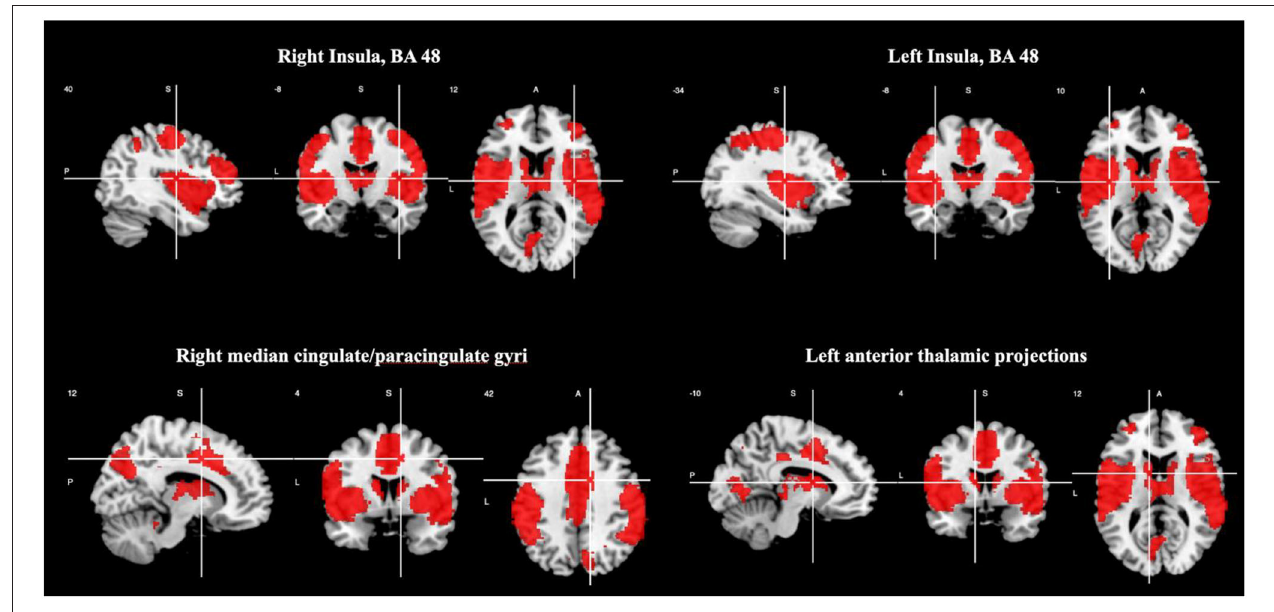
FIGURE 2 | Brain regions engaged during oddball tasks.